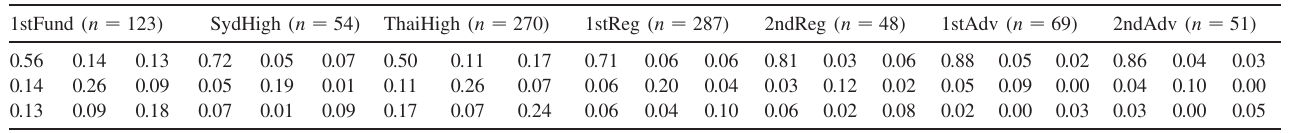
TABLE VI. Average class density matrices for questions 6–8 on longitudinal waves.